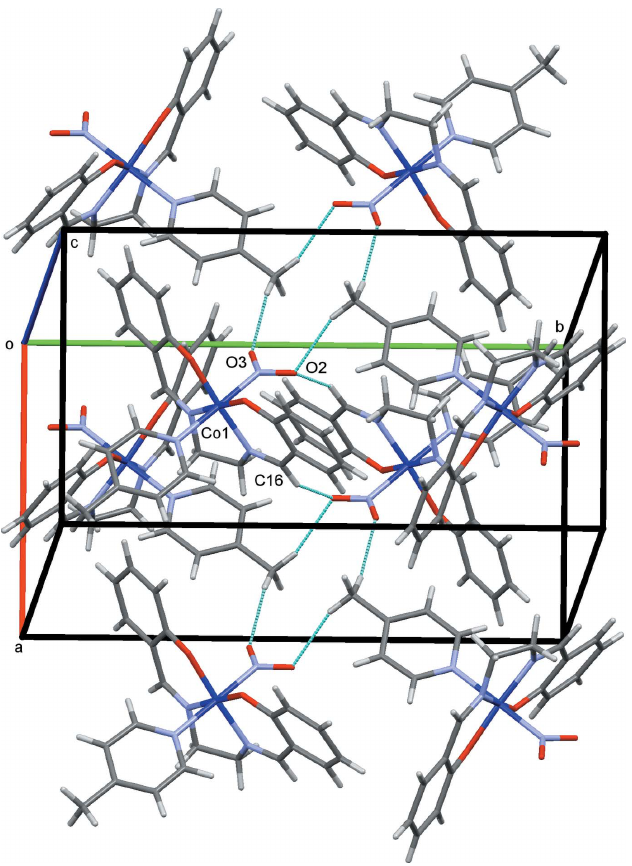
Figure 4 The crystal structure of (II), projected along c . The C—H (cid:2)(cid:2)(cid:2) O hydrogen bonds are shown as blue dashed lines.